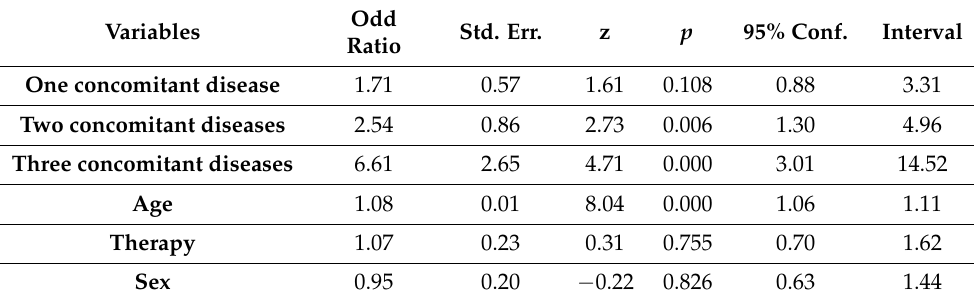
Table 3. Logistic regression